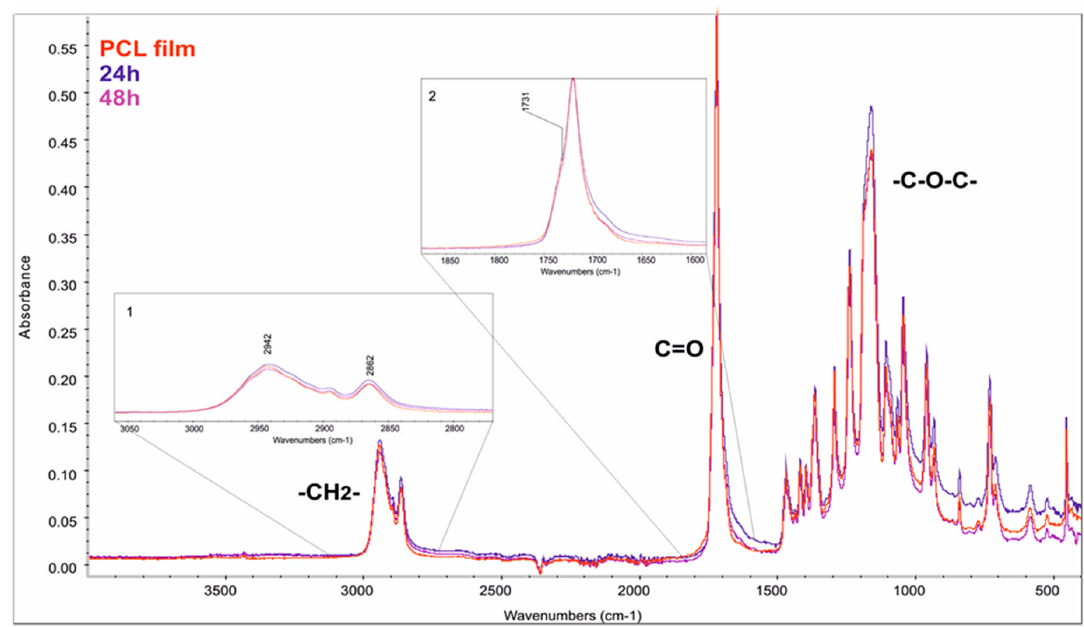
Figure 8. FTIR-ATR spectra of PCL films, before and after the enzymatic degradation, Inset (1) show changes in peaks at 2942 and 2862 cm − 1 ascribed to aliphatic chains. Insets 2: Peak corresponding to C=O bonds of ester groups.